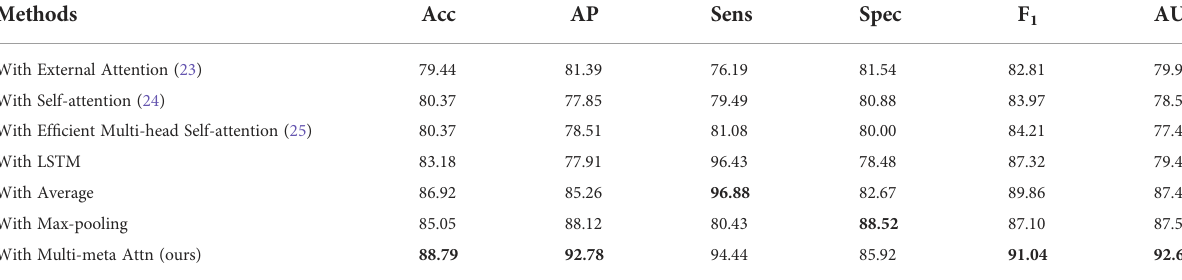
TABLE 3 Quantitative comparisons for the effectiveness of multi-meta attention